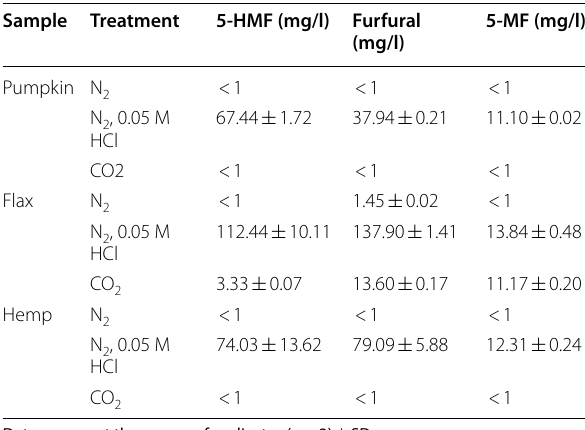
Data represent the means of replicates ( n 5-HMF 5‑hydroxymethylfurfural; 5-MF methyl‑furfural